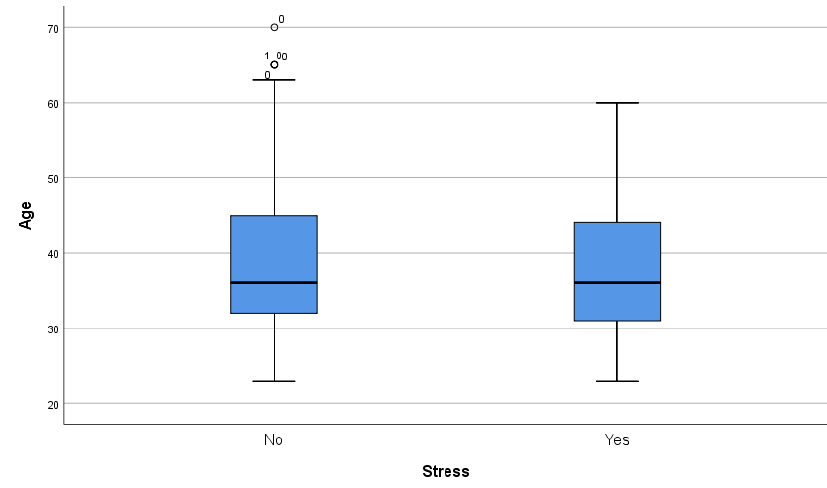
Figure 2. Box and whiskers graph, age, and anxiety diagnosis. 1 women, 0 men, * p < 0.05